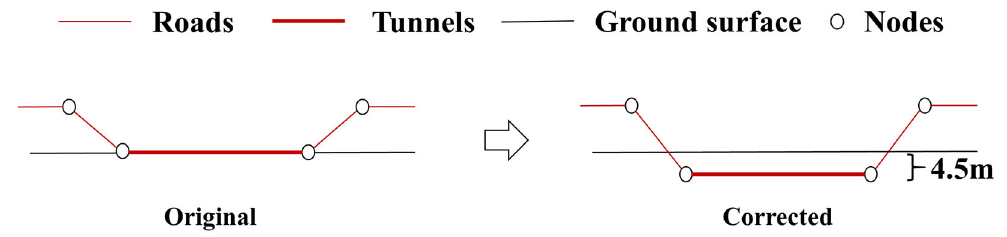
Figure 6. The detailed process for the tunnel correction process.